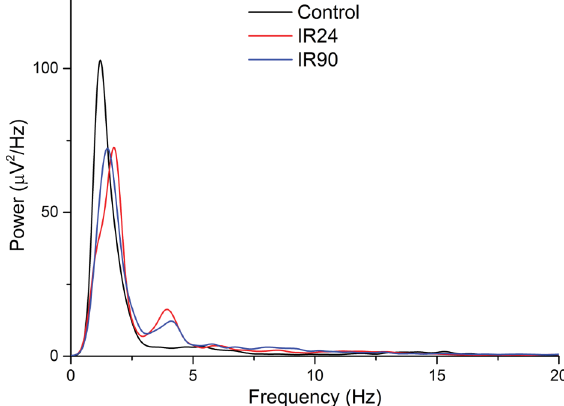
Figure 2. Power spectrum of the electrocorticogram for the following groups: control (black), irradiation evaluated at 24 h (IR24; red) and at 90 days (IR90; blue).